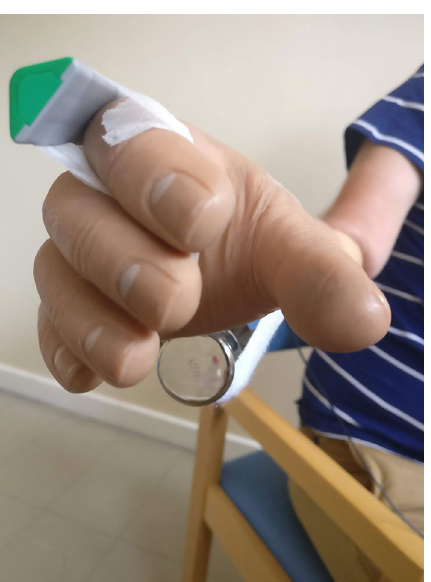
Figure 2. Socket mounted electrodes. Images from participants’ own clinically prescribed prostheses. Note that in the far-left image, the quality of the skin–electrode interface is disrupted by a leather shim on the interior of the socket.